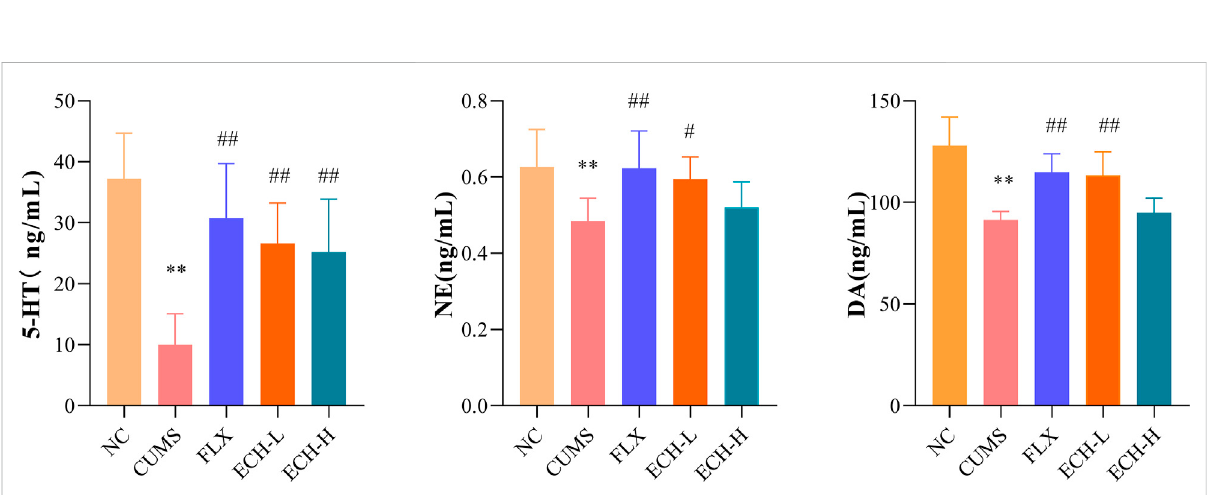
Effects of ECH on 5-HT, NE and DA levels in the hippocampus of CUMS Mice. NC, un-treated normal mice; CUMS, mice were treated with the chronic stimulating factors for 7 weeks to set up the CUMS depression model; FLX, CUMS induced mice were administered with fl uoxetine (10 mg/kg,i.g.) daily for 21 days; ECH-L, CUMS induced mice were administered with echinacoside (15 mg/kg,i.g.) daily for 21 days; ECH-H, CUMS induced mice were administered with echinacoside (60 mg/kg,i.g.) daily for 21 days n = 6/group. ** p < .01 compared with control group; # p < .05, ## p < .01 compared with CUMS